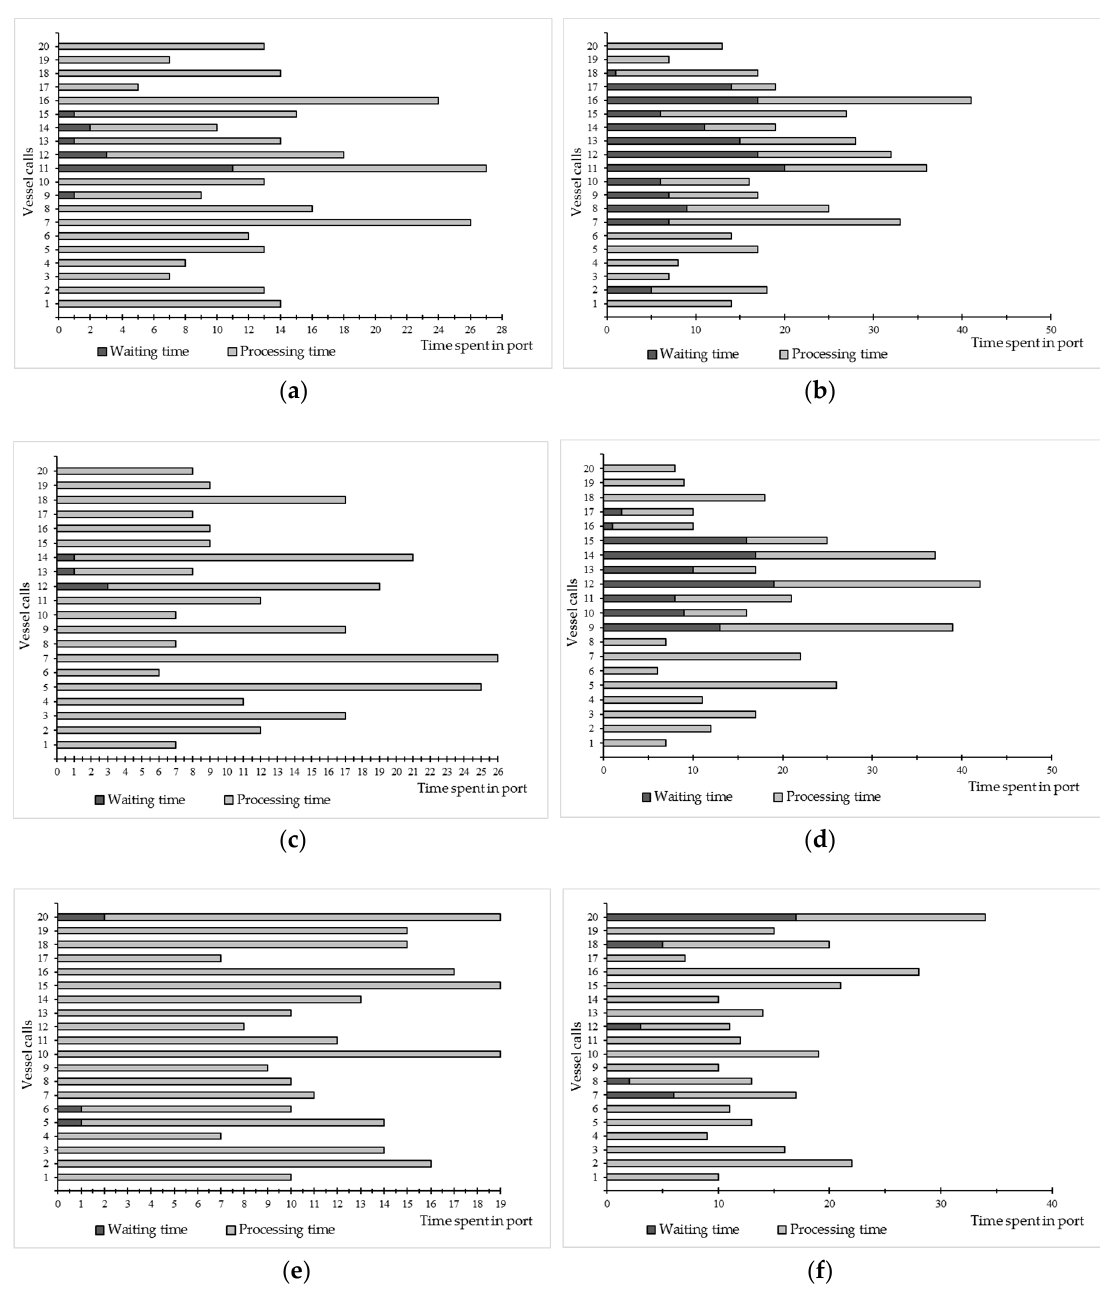
Figure 6. The relation between waiting time and the total ship service time—integrated model with early arrival adjustment (left) vs. classical approach—first in, first serve—with terminal preferences (right): ( a , b ) Case 7; ( c , d ) Case 10; ( e , f ) Case 11.